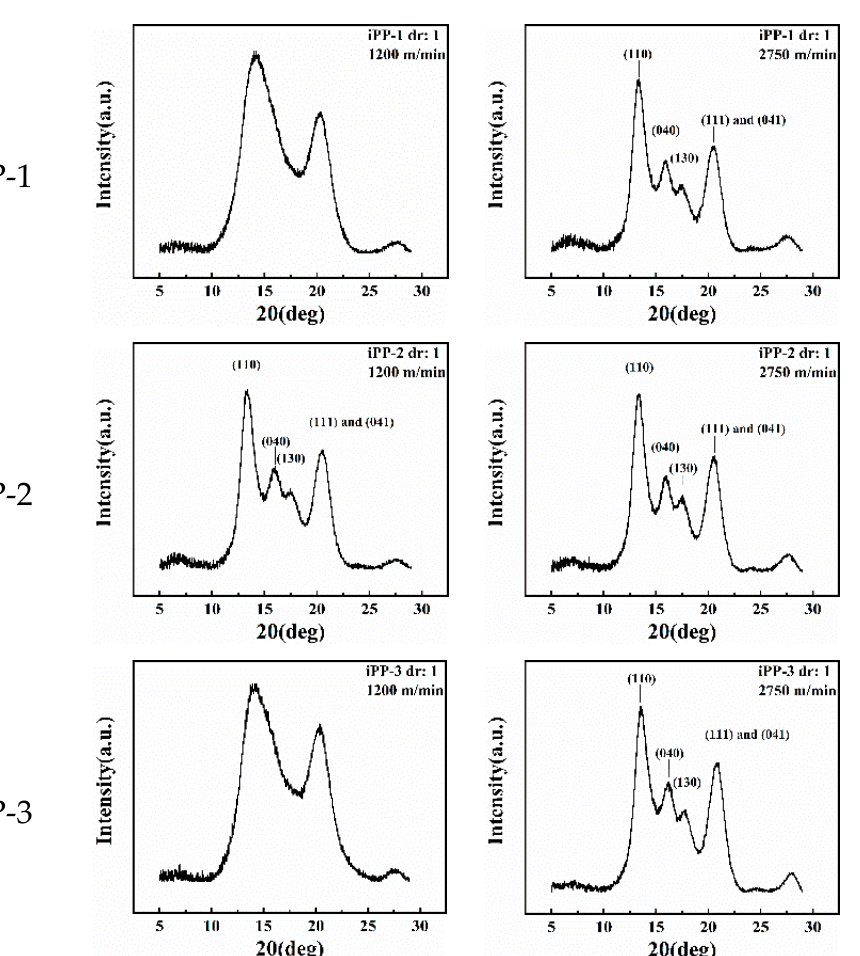
Figure 9. 1D WAXD curves of as-spun iPP fibers.